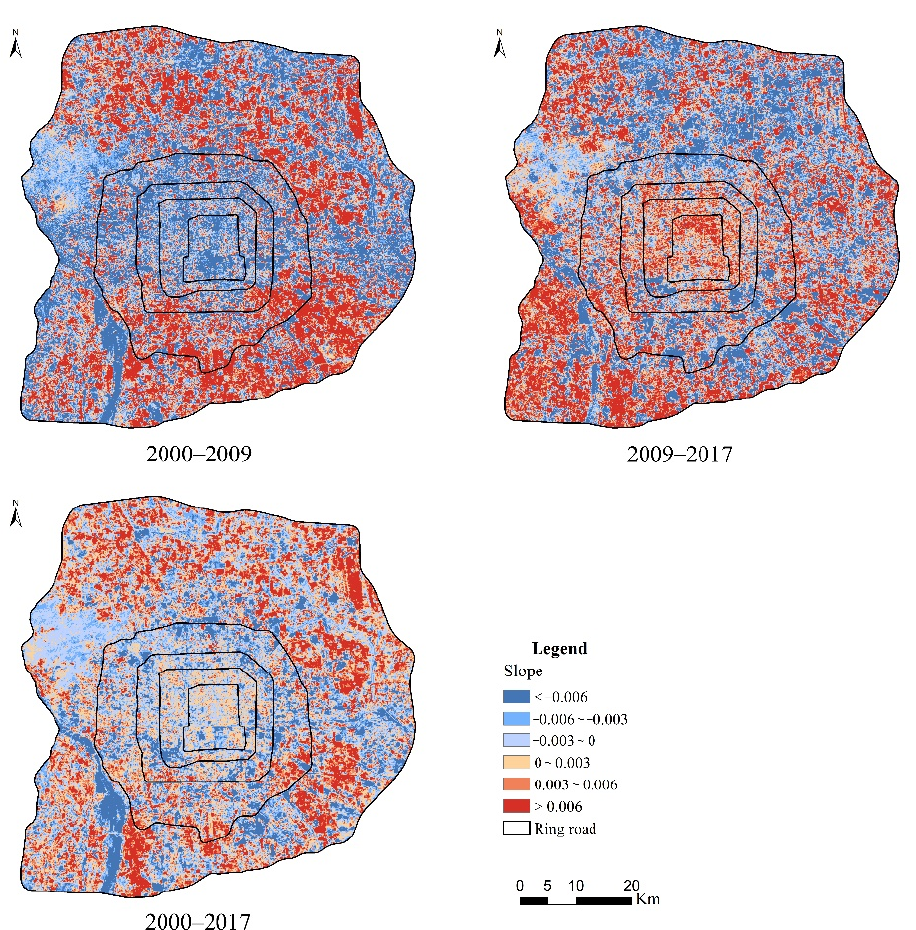
Figure 7. Spatial distribution of the Theil–Sen regression slope of LST R . From 2000 to 2017, the most significant area of sUHI intensity enhancement was outside the 5th Ring Road, and the sUHI intensity in the region of the 3rd Ring Road increased slightly. In this period, a large area presented a sUHI intensity enhancement trend between the 3rd and 5th Ring Roads.